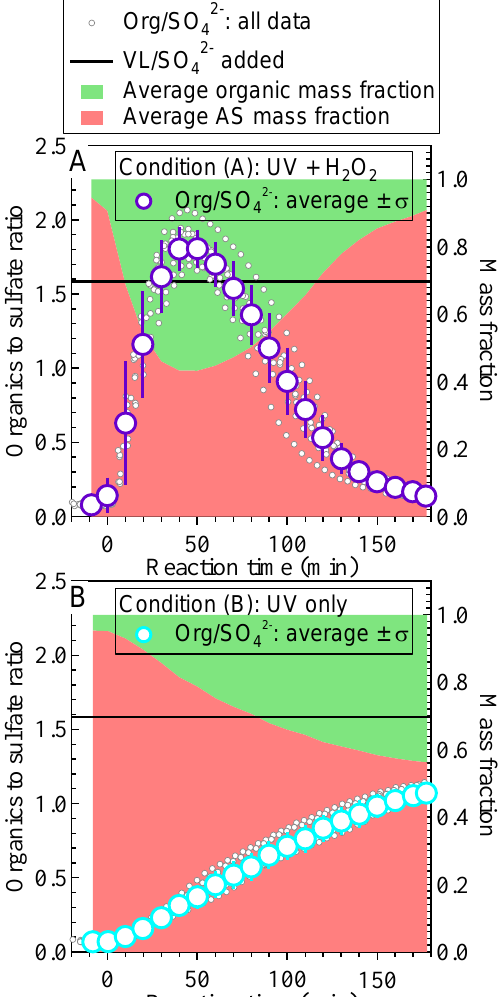
Fig. 1. Ratios of organics to sulfate, as well as mass fractions of organic and ammonium sulfate during experiments under conditions (A) and (B). Small grey symbols show data from all experiments (A_1 to A_8 or B_1 to B_6), while large color symbols show 10-minute running averages with error bars representing standard deviations.